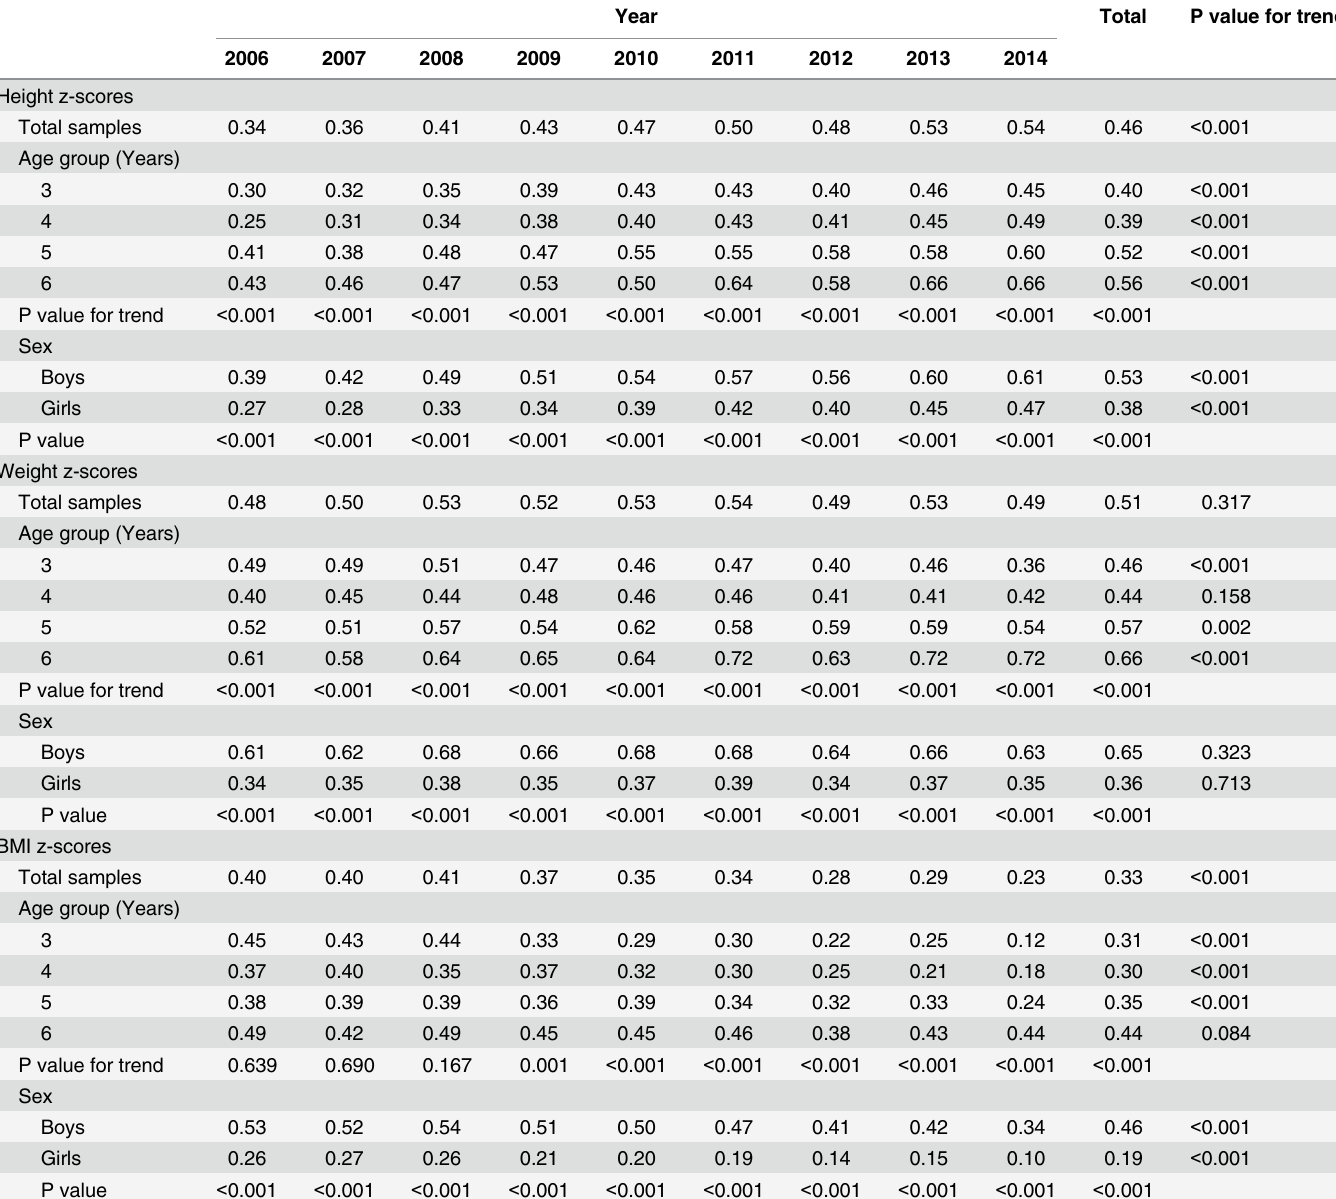
Table 2. Mean values of z-scores for weight, height and BMI in the children at 3 – 6 years in Tianjin from 2006 to